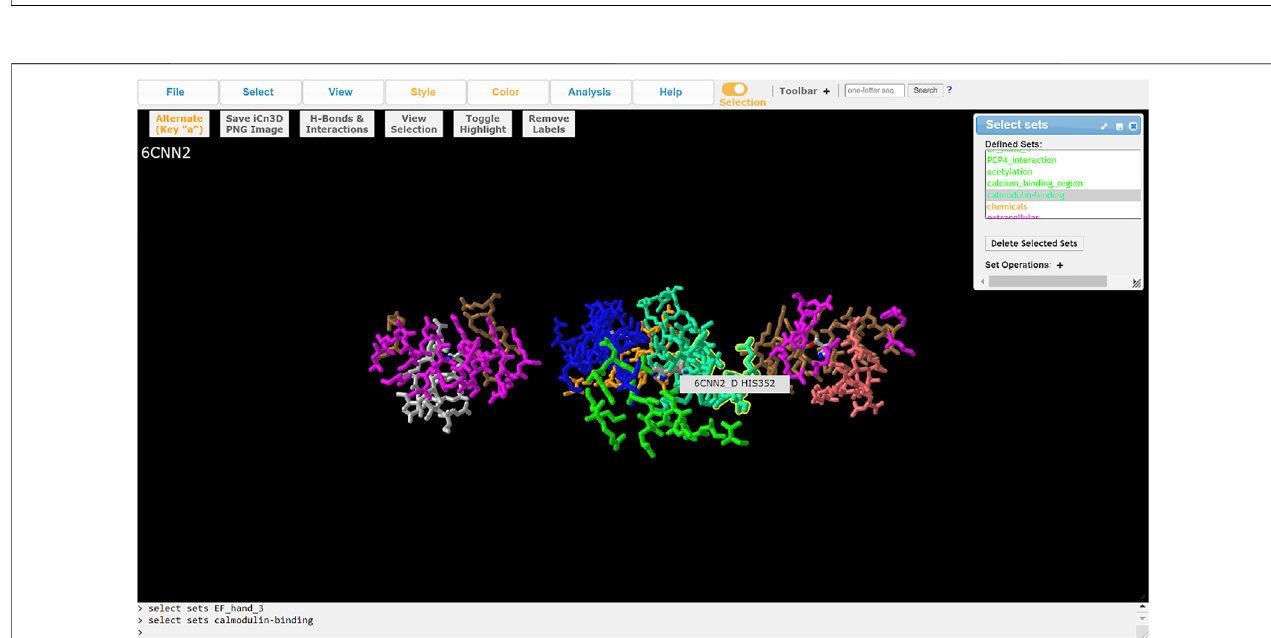
FIGURE2| Visualizationofdiltiazemblocking theCa V 1.1 channel pore (PDB: 6JPB). Diltiazem interactswith threeconservedresidues (Y1365, A1369,and I1372) on the intracellular side of the channel to block calcium conductance. Ca 2+ ions shown as gray spheres. The alanine residue (A1369) is centered, with the diltiazem molecule visibly blocking the channel pore.